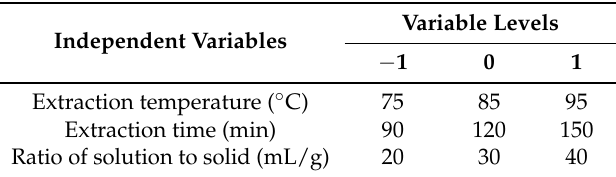
Table 3. Independent variables and their levels for Box-Behnken